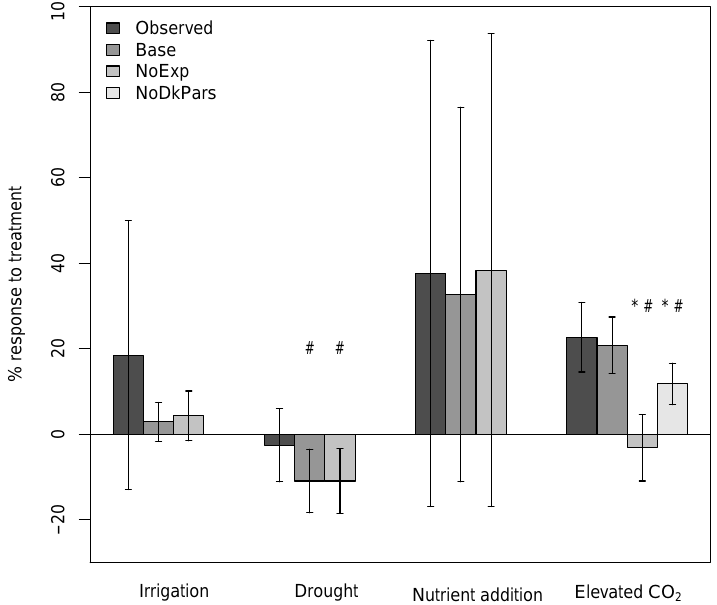
Figure 5. The mean response, expressed as a percentage change in stem biomass from the control treatment, for irrigation, drought (as a reduction in throughfall), nutrient addition, and elevated CO 2 experiments. The observed response and the response simulated by the Base, NoExp, and NoDkPars assimilation approaches are shown. The # sign signifies that the value below the marker was significantly different from the observed response ( p <0.05). The * sign signifies that the value below the marker was significantly different from the response in the Base assimilation ( p <0.05). Error bars are ± 1 standard